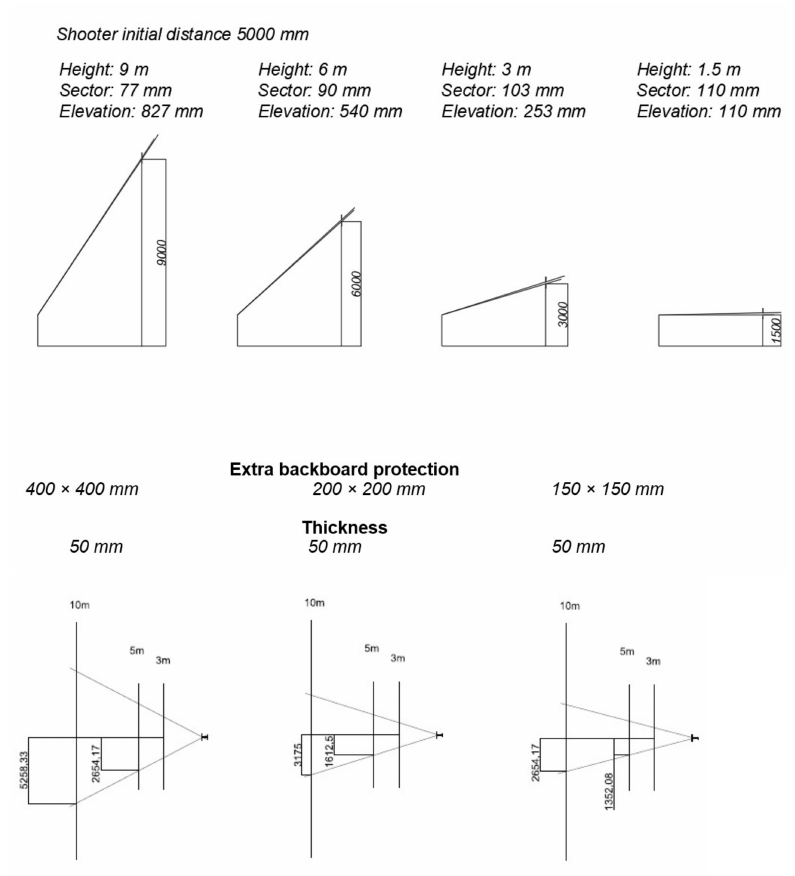
Figure 12. The possible shooting positions, angle